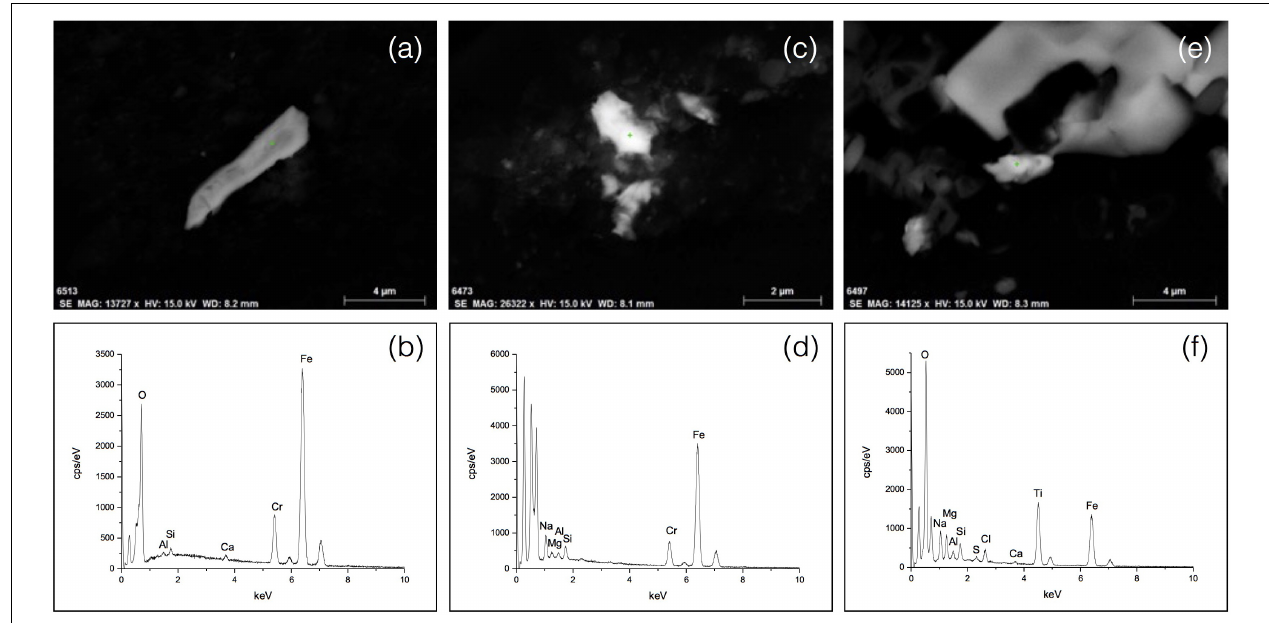
FIGURE 9 | Scanning electron microscopy micrographs and EDS spectra of (a,b) a Fe-Cr bearing hyaloclastic fragment, (c,d) a Fe-Cr bearing fragment internally mixed with alkaline sulfate, and (e,f) aTi-Fe bearing metal oxide particle externally mixed with alkaline sulfate, sodium chloride and silicate minerals. The green crosses mark the spot